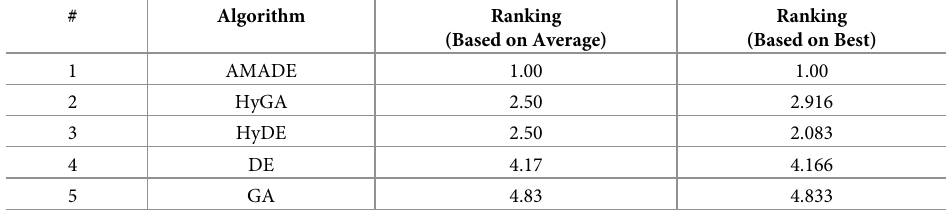
Table 4. Friedman tests based on the average and best intra-clusters distances obtained by